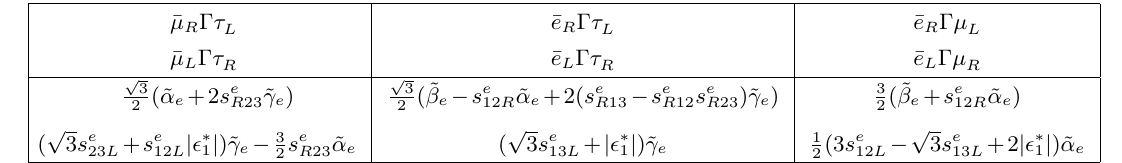
Table 2 . A 4 flavor coefficients of the FC lepton bilinear operators at τ = i + (cid:15) , where O ( | (cid:15) | 2 ) is neglected because the modular forms are expanded in O ( | (cid:15) | ) , and ˜ α e = (6 − 3